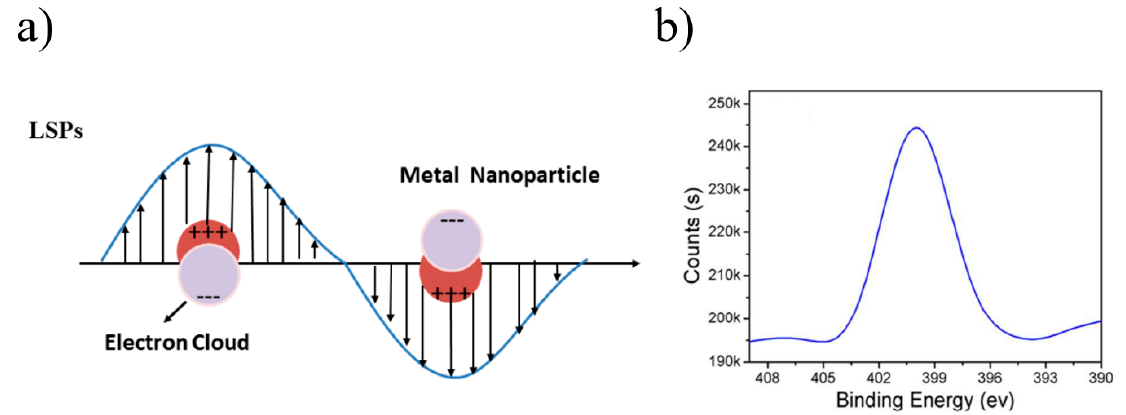
Figure 1. ( a ) Typical localized surface plasmon resonance of gold nanospheres [39]; ( b ) absorption spectrum of gold nanospheres [40].